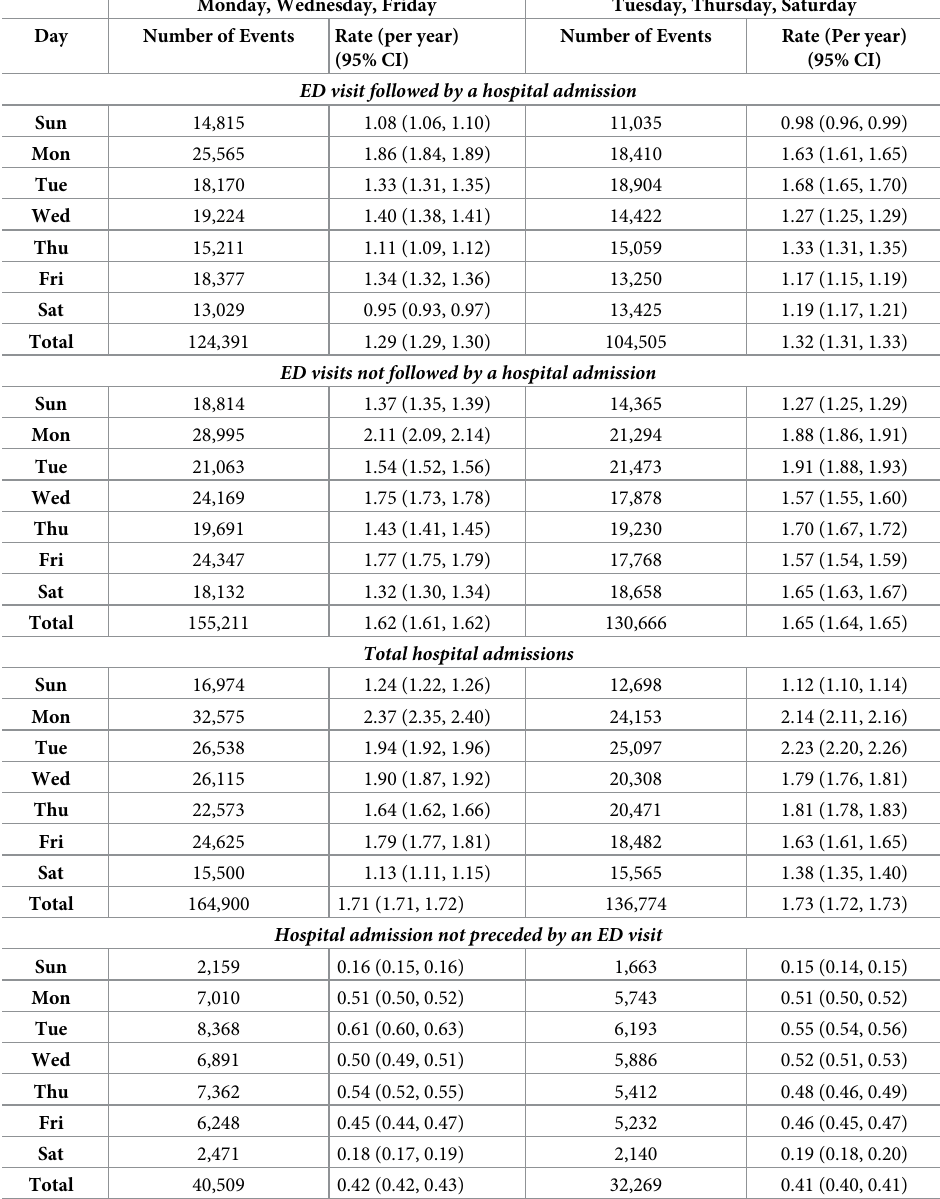
Table 2. Number and rate (per year) of all-cause total ED visits, ED visits followed by hospital admission, ED vis- its not followed by hospital admission, total hospital admissions, and hospital admission not preceded by an ED visit, among in-center HD patients, by dialysis schedule and day of the